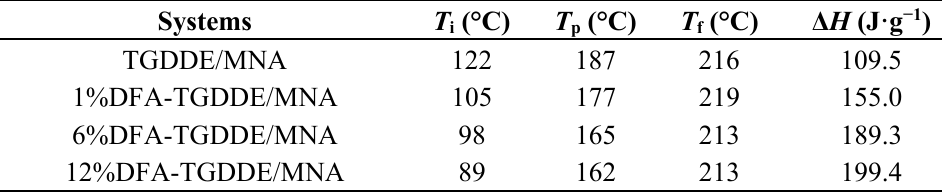
Figure 4. DSC curves of TGDDE and DFA-TGDDE curing with methyl nadic anhydride (MNA), 5 °C/min. Table 1. Characteristics of the curing systems, 5